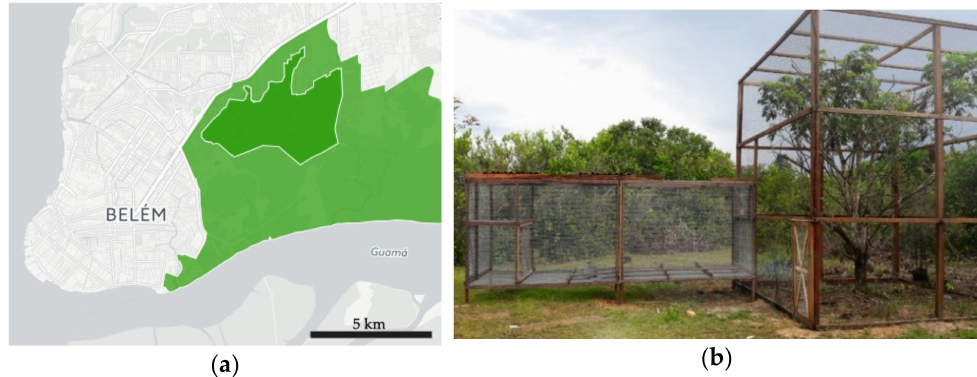
Figure 1. ( a ) The Utinga State Park (dark green), located inside the environmental protected area (light green). ( b ) The acclimatization aviary is composed of two modules